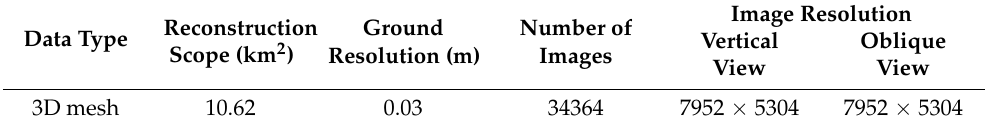
Table 1. Experimental data